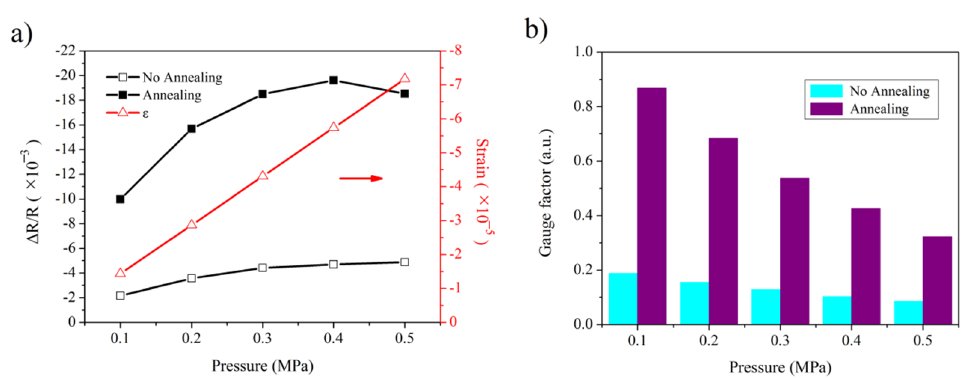
Figure 4. Simulative strain fields for cavity membrane: ( a ) strain xx ential pressure with 0.1 MPa; ( b ) xx